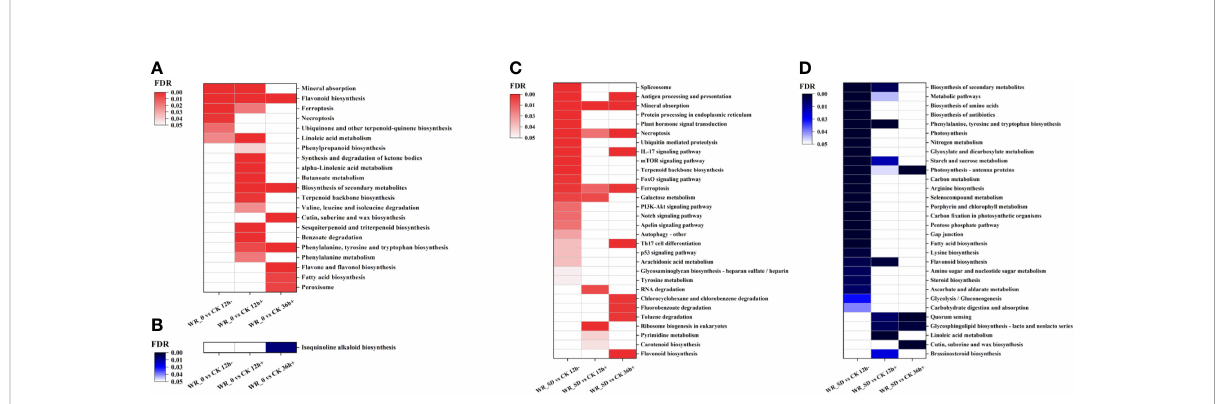
FIGURE 7 KEGG pathways enriched in DEGs of pairwise comparisons within the entire WR_ q cri vs. CK set and WR_SD vs. CK set. (A) , KEGG pathways enriched in upregulated DEGs within the WR_ q cri vs. CK set. (B) , KEGG pathways enriched in downregulated DEGs within the WR_ q cri vs. CK set. (C) , KEGG pathways enriched in upregulated DEGs within the WR_SD vs. CK set. (D) , KEGG pathways enriched in downregulated DEGs within the WR_SD vs. CK set. The top 30 signi fi cant ( P <0.01) KEGG pathways are shown in the graph, and the FDR value of each item was used to draw a